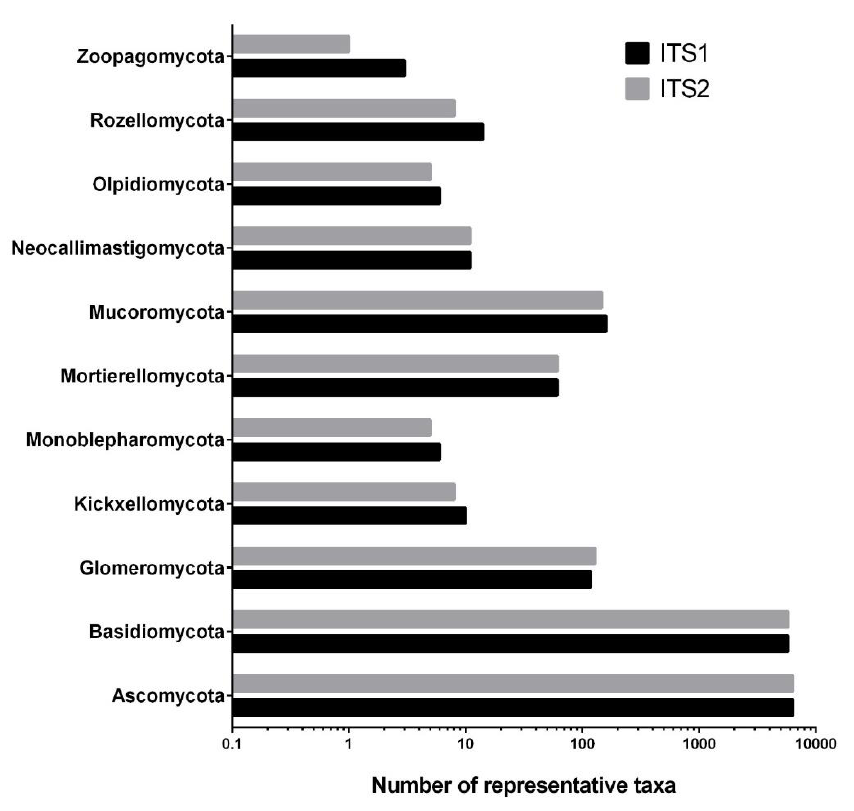
Figure 2. Number of representative taxa in the 11 phyla of the UNITE database. Data was separated according to the sequences retrieved with primers targeting ITS1 and ITS2.